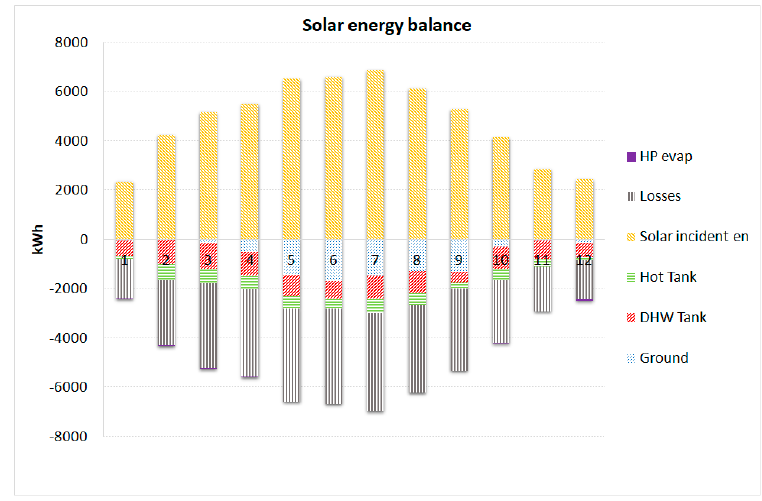
Figure 11. Solar energy balance for the A3 alternative.